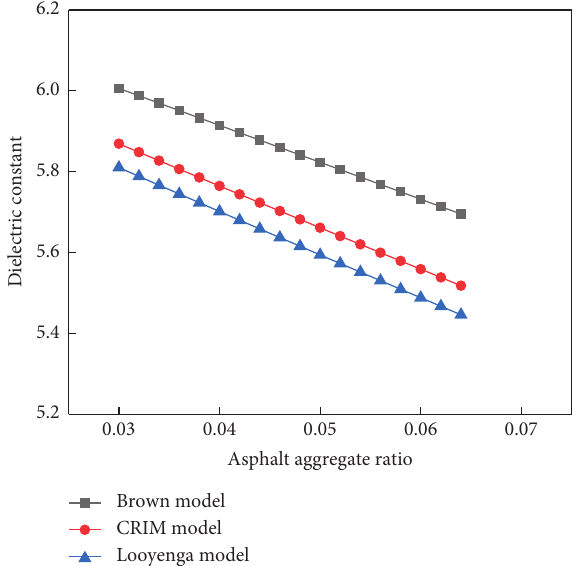
Figure 7: Theoretical calculation